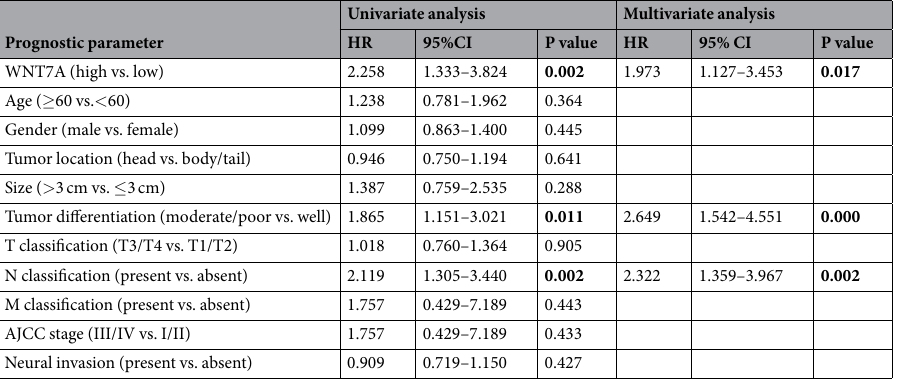
Univariate analysis Multivariate analysis Prognostic parameter HR 95%CI P value HR 95% CI P value